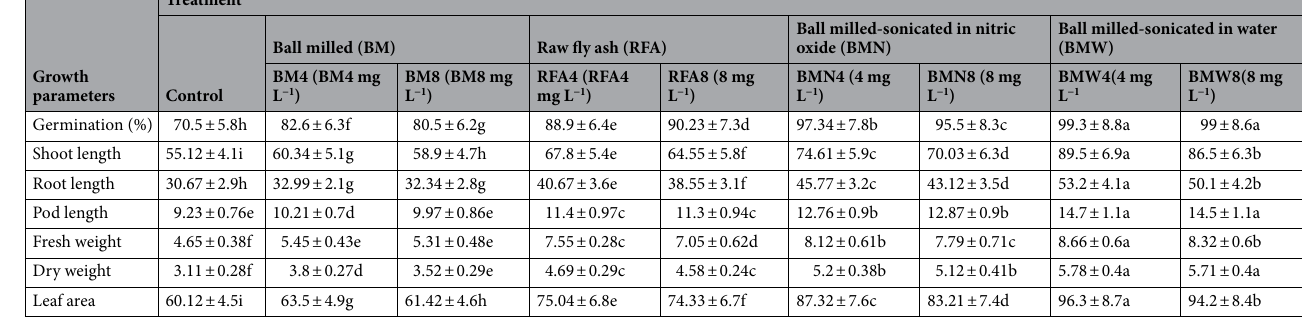
Table 1. Impact of CNP treatments on the growth parameters of Phaseolus vulgaris seedlings. The standard deviations (SD) are for three replicates, and the different letters denote treatment differences that are statistically significant.